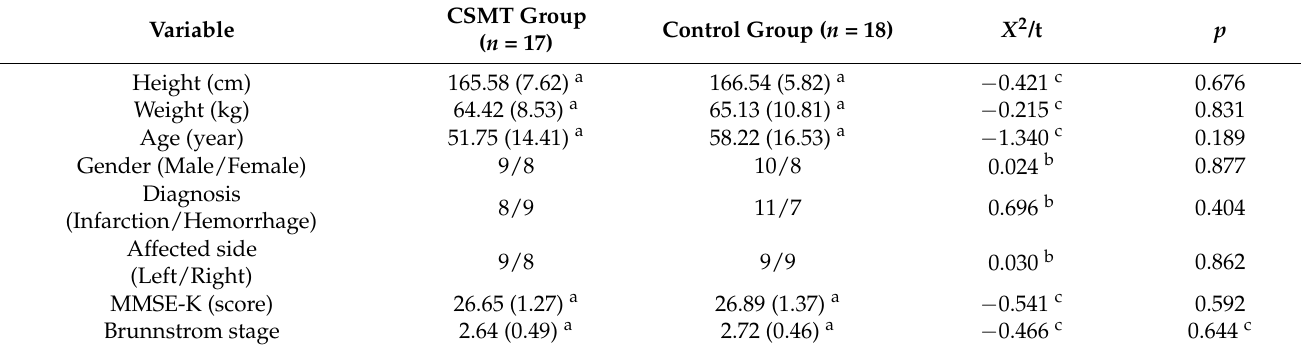
Table 2. General and clinical Characteristics of Subjects ( N = 35).